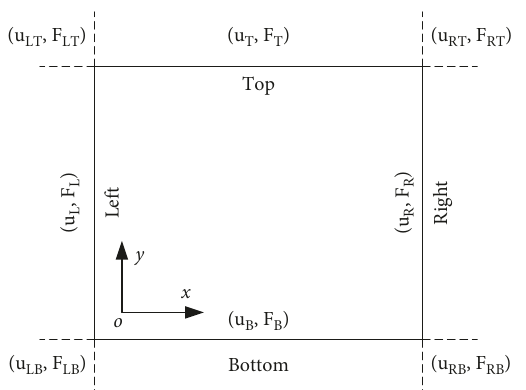
Figure 3: Schematic diagram of components of displacement and forces.